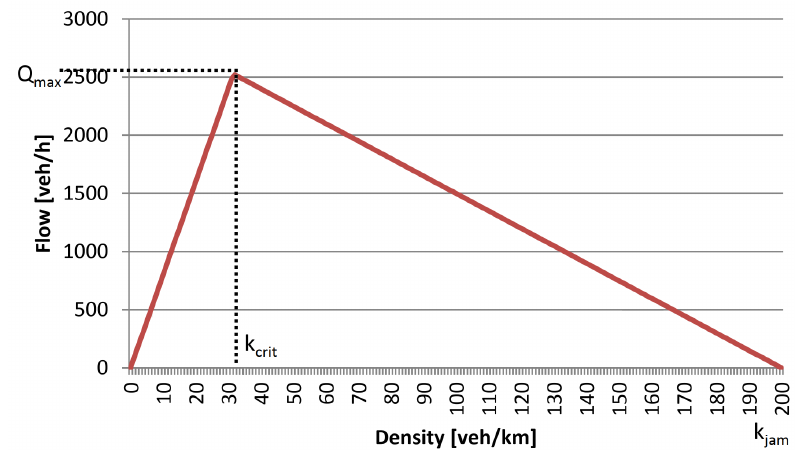
Figure 3. The flow-density curve [14]. k crit depicts the turning point from normal traffic flow to congested traffic